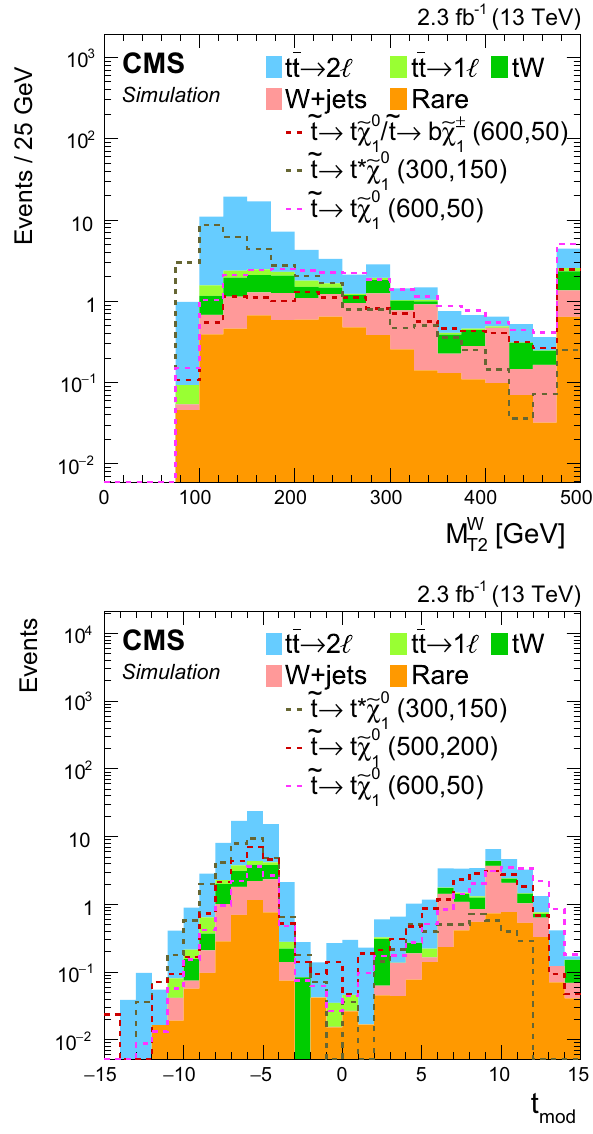
Fig. 4 The M W ( top ) and t mod ( bottom ) distributions for signal and T2 backgrounds after the preselection are shown. The M W shown for events with four or more jets, while t mod is shown for events with at least two jets. Signal models with different top squark and neu- tralino mass hypotheses are shown for